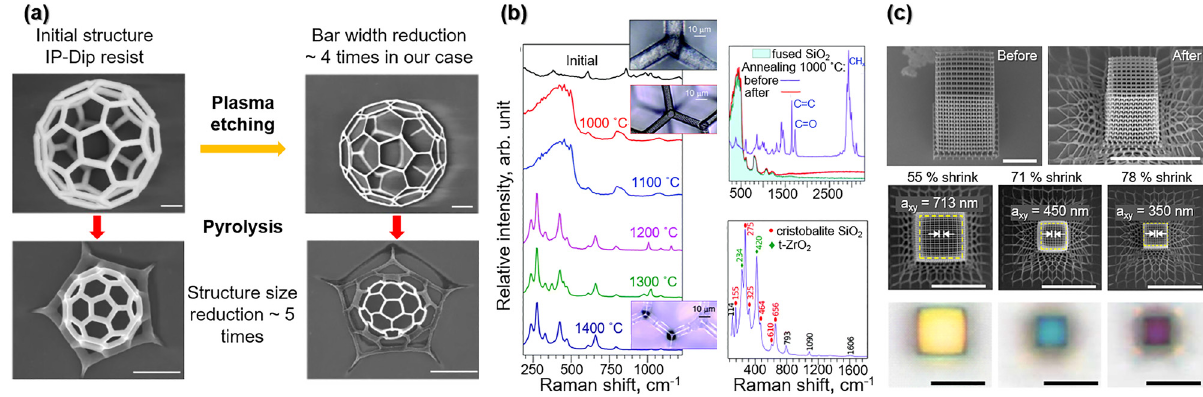
Figure 10: Thermal post-processing of structures, manufactured via MPL.